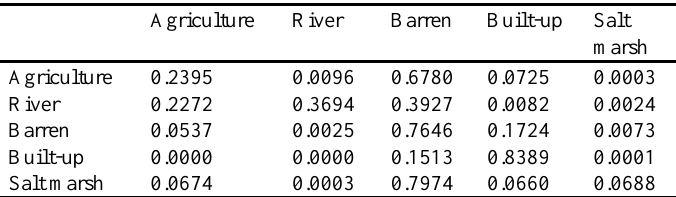
Table 2. Ahvaz transition probability matrix 1986 - 2000